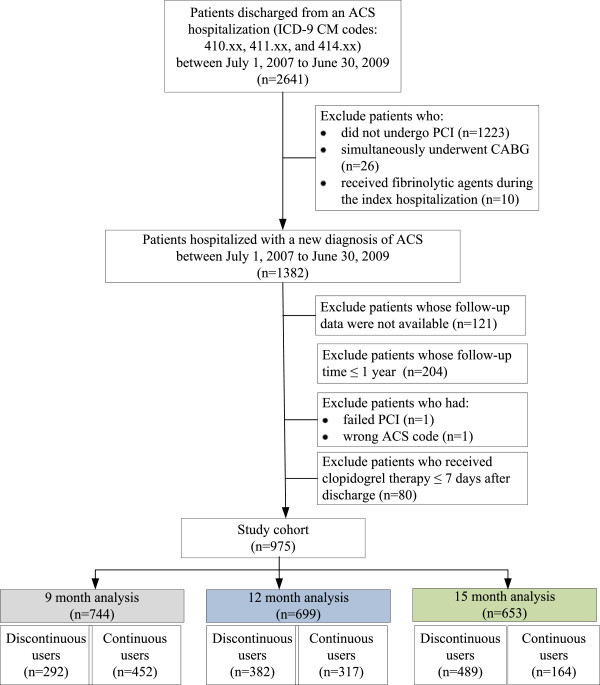
Study flowchart.